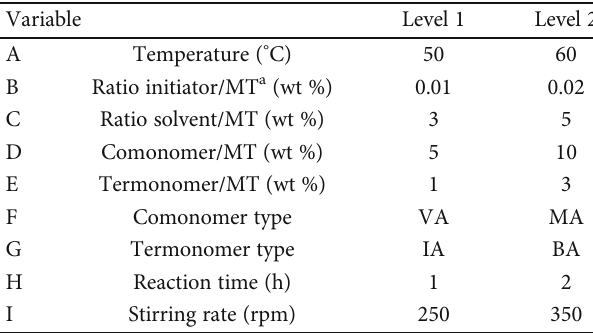
Table 1: Variables and tested values for the experimental design of terpolymerization